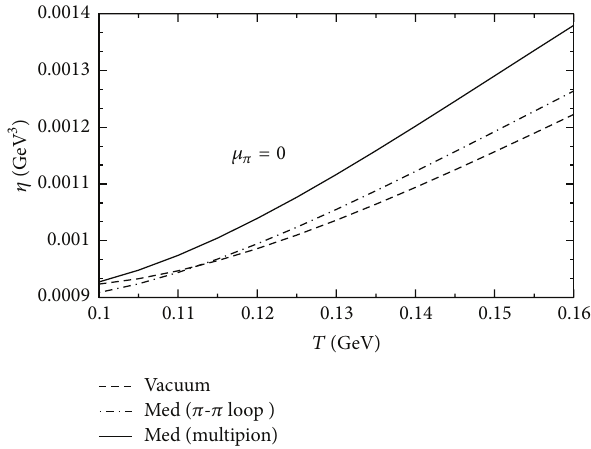
Figure 6: The shear viscosity as a function of temperature in the relaxation time approximation. The dash-dotted and solid lines correspond to the use of in-medium cross-sections in (84) for 𝜋𝜋 and multipion loops, respectively. The dashed line represents the vacuum case.